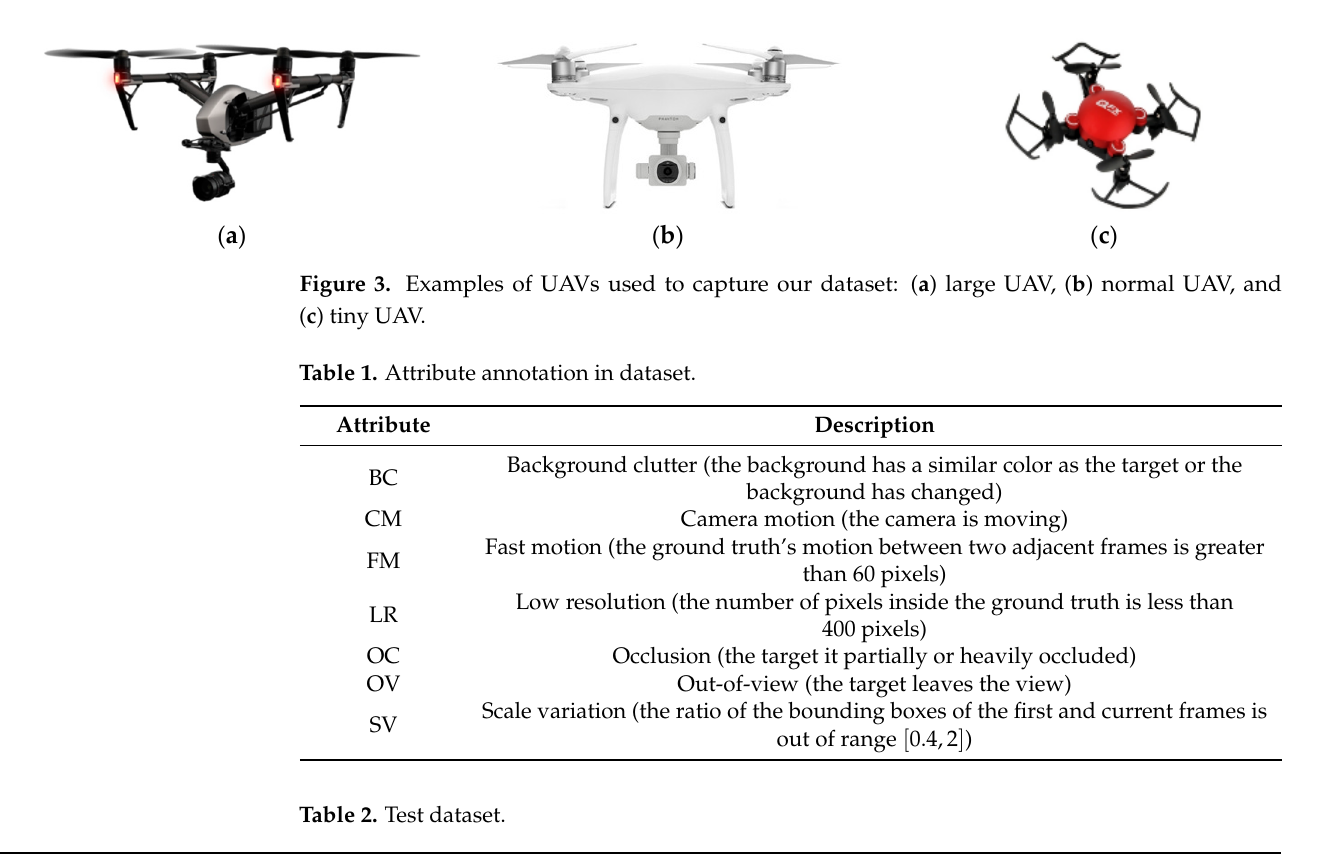
Figure 2. Screenshots taken from our dataset: ( a ) cloud background, ( b ) river background, ( c ) moun- tain background, ( d ) building background, ( e ) large target, ( f ) medium target, ( g ) small target, and ( h ) tiny target.